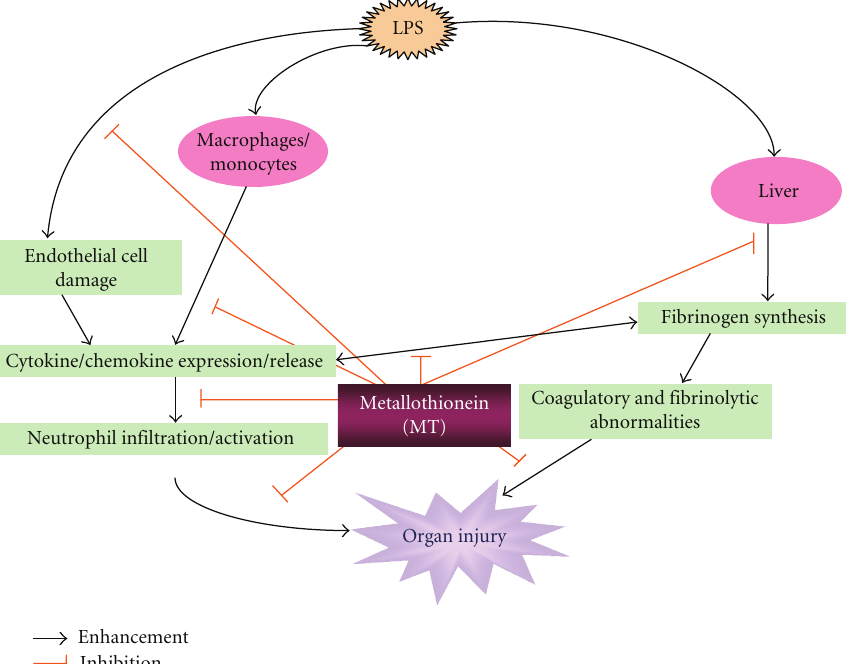
Figure 1: Hypothesized mechanisms of cytoprotection of MT in LPS-related inflammation. Figure reproduced with some modifications with permission from FASEB journal